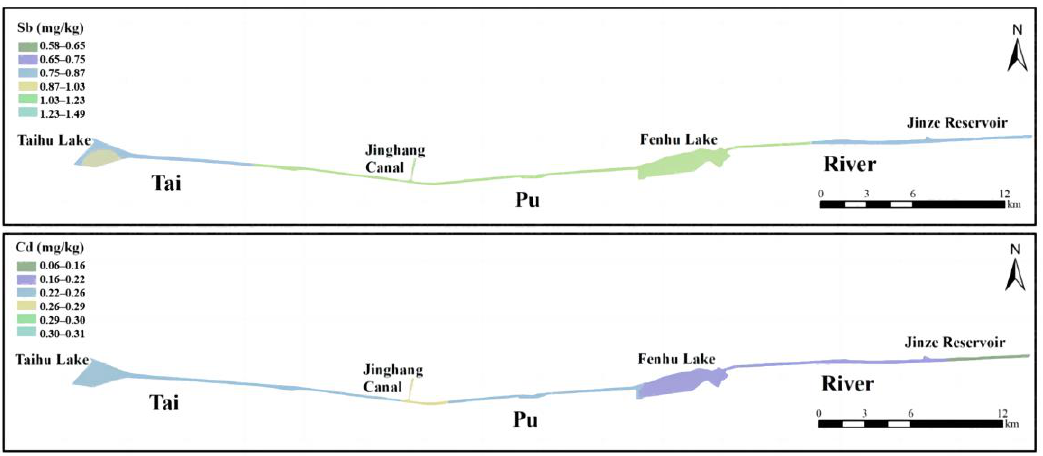
Figure 7. Counter maps of BV of Sb and Cd in the Taipu River sediments.